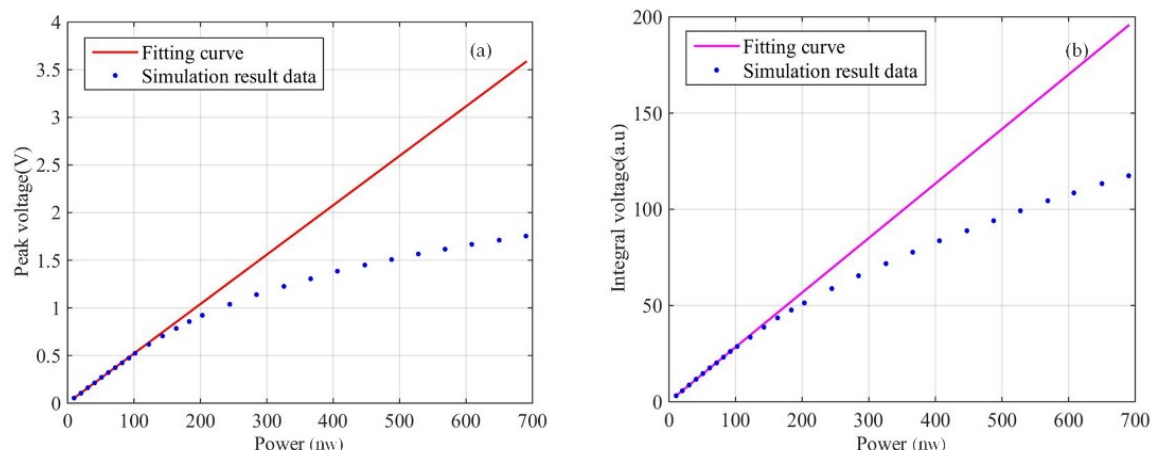
Figure 9. The green line is the input signal and the red line is the output signal of the original airborne ACB in simulation.